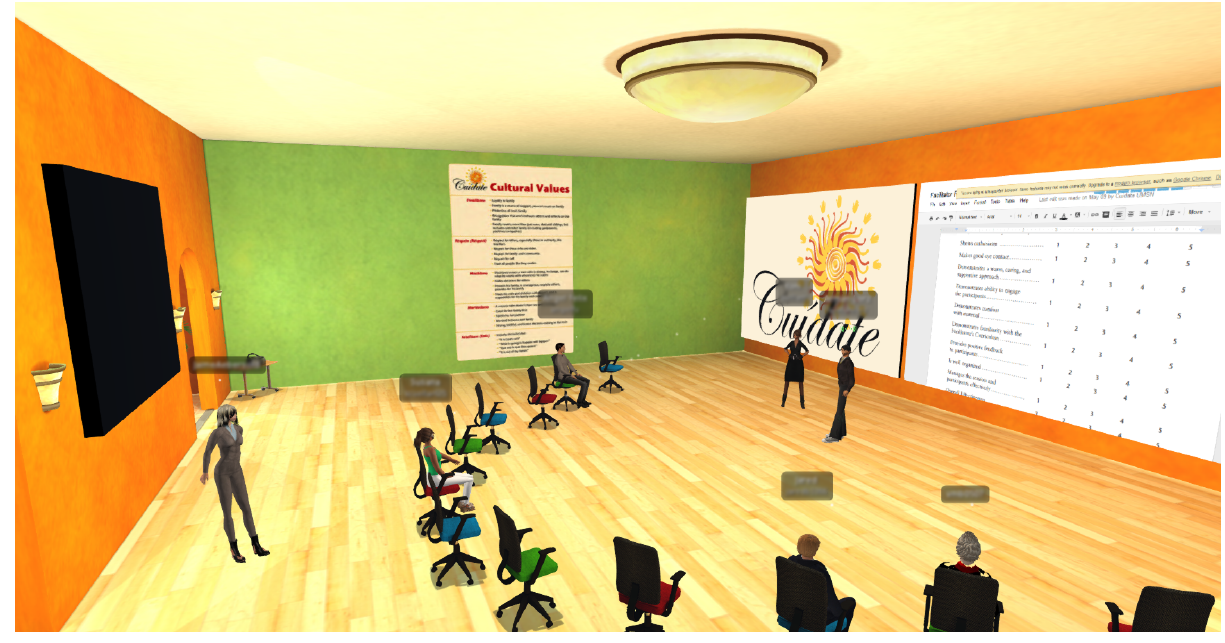
Figure 1. ¡Cuídate! training room in Second